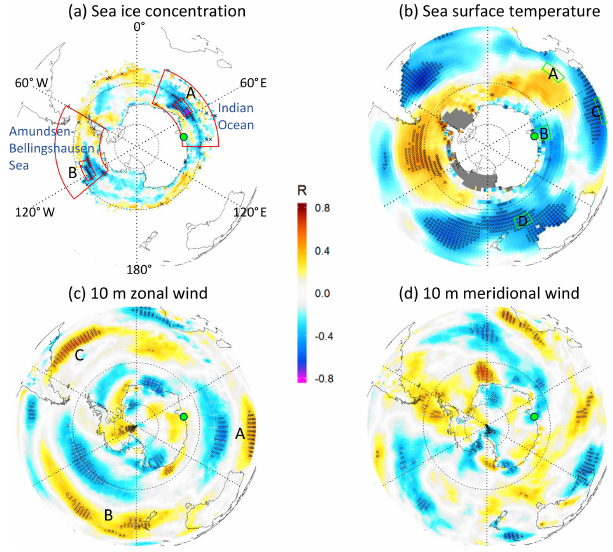
Figure 9. Correlation maps of Davis OH 24-year QQO signal (green dot) with (a) sea ice concentration (OI-SST; Reynolds et al., 2002), (b) sea surface temperature (ERSSTv5), (c) surface (10m) zonal wind anomaly (ERA5) and (d) surface (10m) meridional wind anomaly (ERA5). Hashed areas are significant at the 90% level.